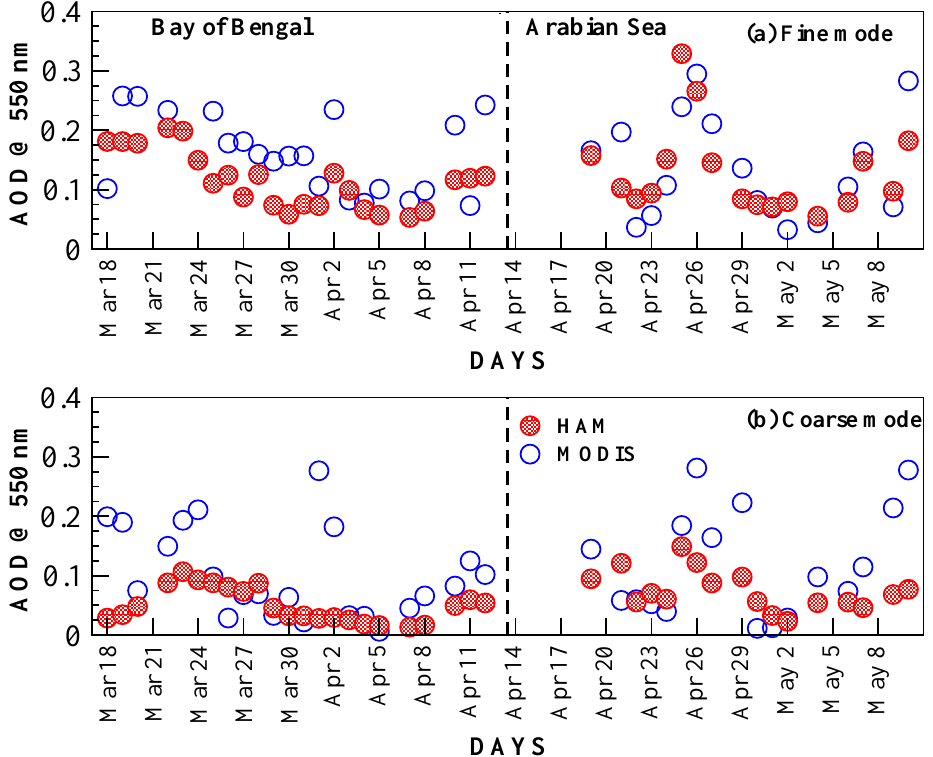
Fig. 4. Comparison of modelled fine ( a : upper panel) and coarse mode ( b : lower panel) AODs at 550nm against satellite observations during the ICARB 2006 cruise period.